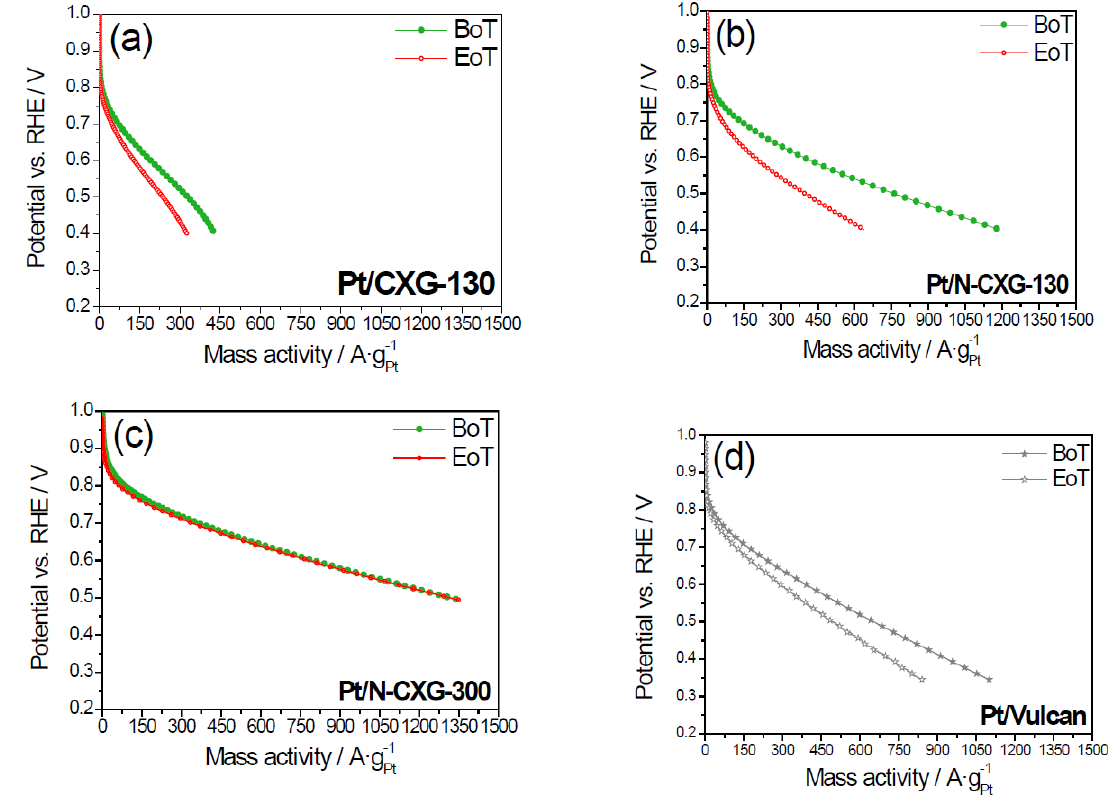
Figure 8. Linear sweep voltammetries obtained in a gas diffusion electrode (GDE) feeding O 2 to the backing layer of the electrode at the beginning of test (BoT) and at the end of test (EoT), consisting of 1000 cycles between 0.6 and 1.2 V vs. RHE. 0.5 M H 2 SO 4 solution; scan rate: 5 mV·s −1 ; 0.1 mg Pt cm −2 .